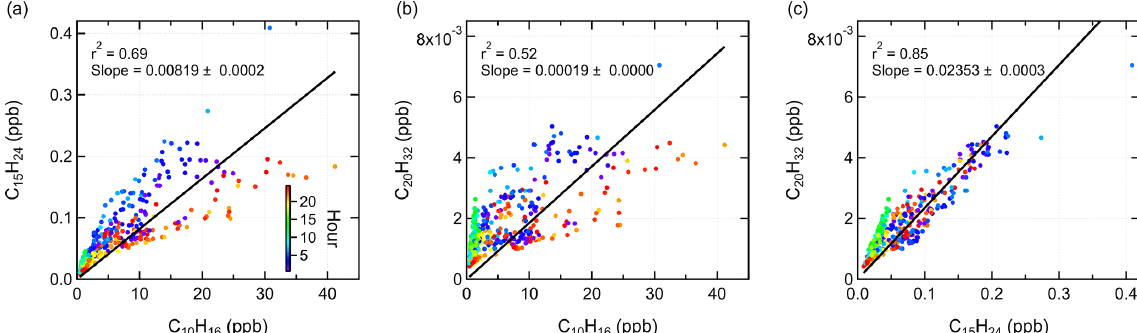
Figure 5. Scatter plots of (a) C 15 H 24 vs. C 10 H 16 , (b) C 20 H 32 vs. C 10 H 16 , and (c) C 20 H 32 vs. C 15 H 24 , colored by time of the